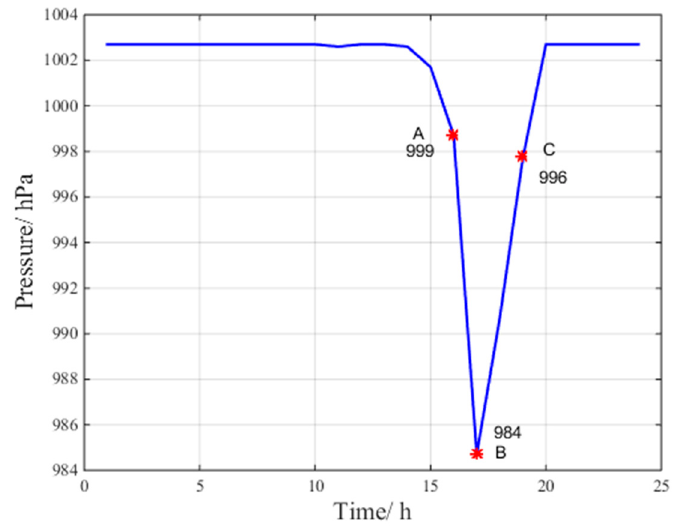
Figure 4. Abnormal pressure condition.